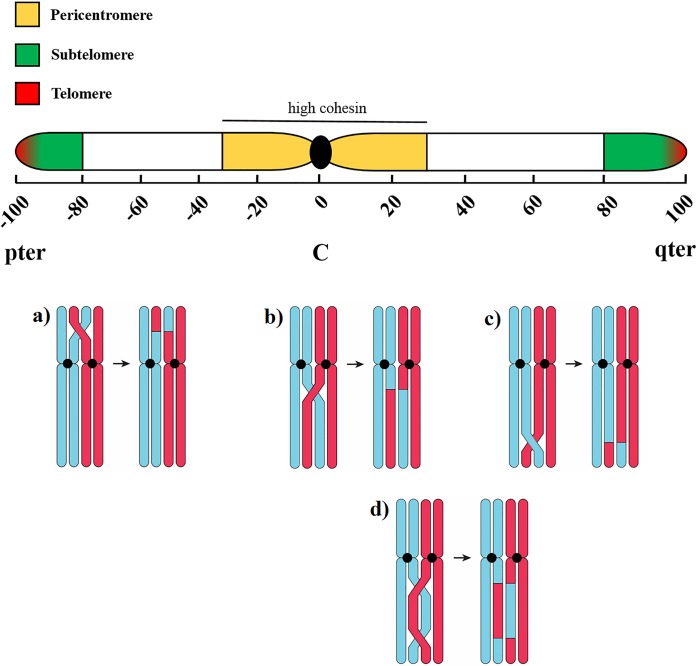
Diagram depicting meiotic crossovers in regions along a chromosome.The p and q arms of the chromosome are divided into 10% intervals, with the centromere (C) at 0%, and telomeres at 100%. The subtelomere is shaded in the 80–100% intervals. The pericentromere, the region surrounding the centromere is shaded in the 10–30% intervals. This region attracts high levels of cohesin which are protein complexes that hold sister chromatids together until they separate during meiosis. Crossover formation in each region of the chromosome, and the resulting recombinant chromosomes are illustrated: a) a single crossover near the telomere on the p-arm; b) a single crossover near the centromere on the q-arm; c) a single crossover near the telomere on the q-arm; d) double crossovers on the q-arm.